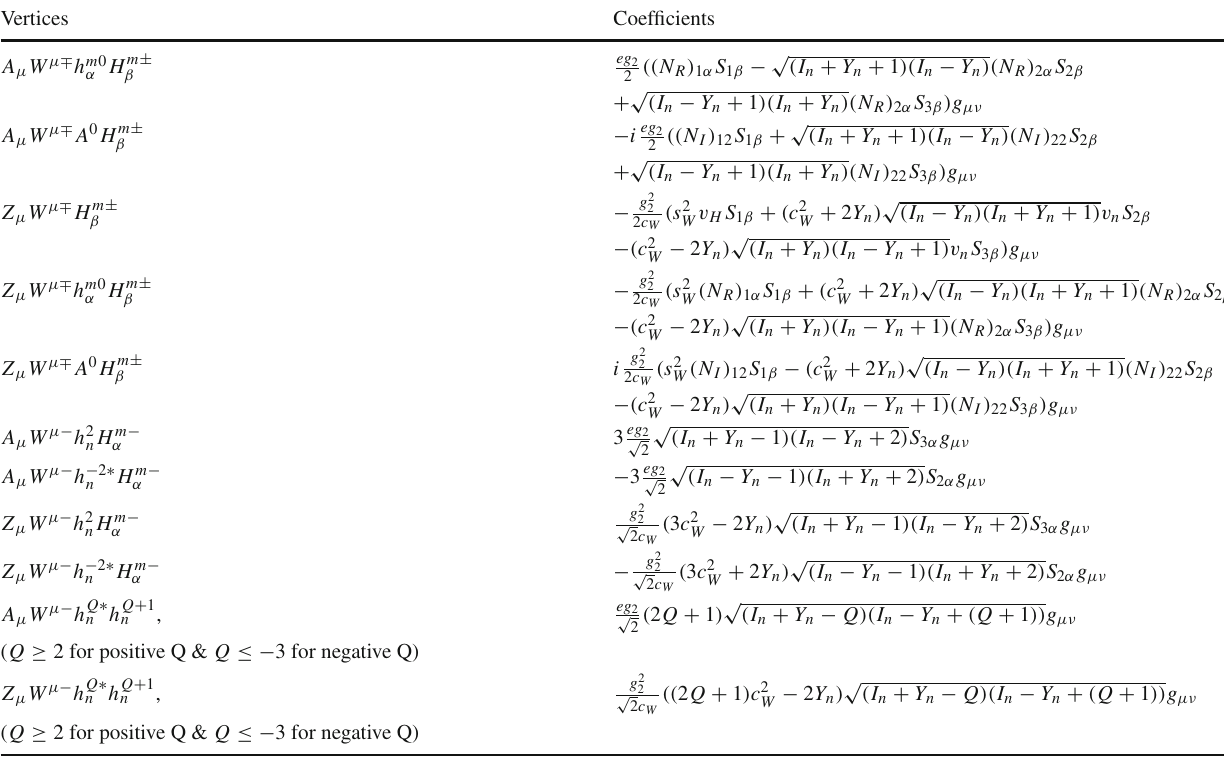
Table 5 Feynman Rules (continued). It is noted that there is no coupling of physical singly charged Higgs boson to γ W ± . After removing the would-be Goldstone boson, the interaction of A μ W μ ± H m ∓ β becomes